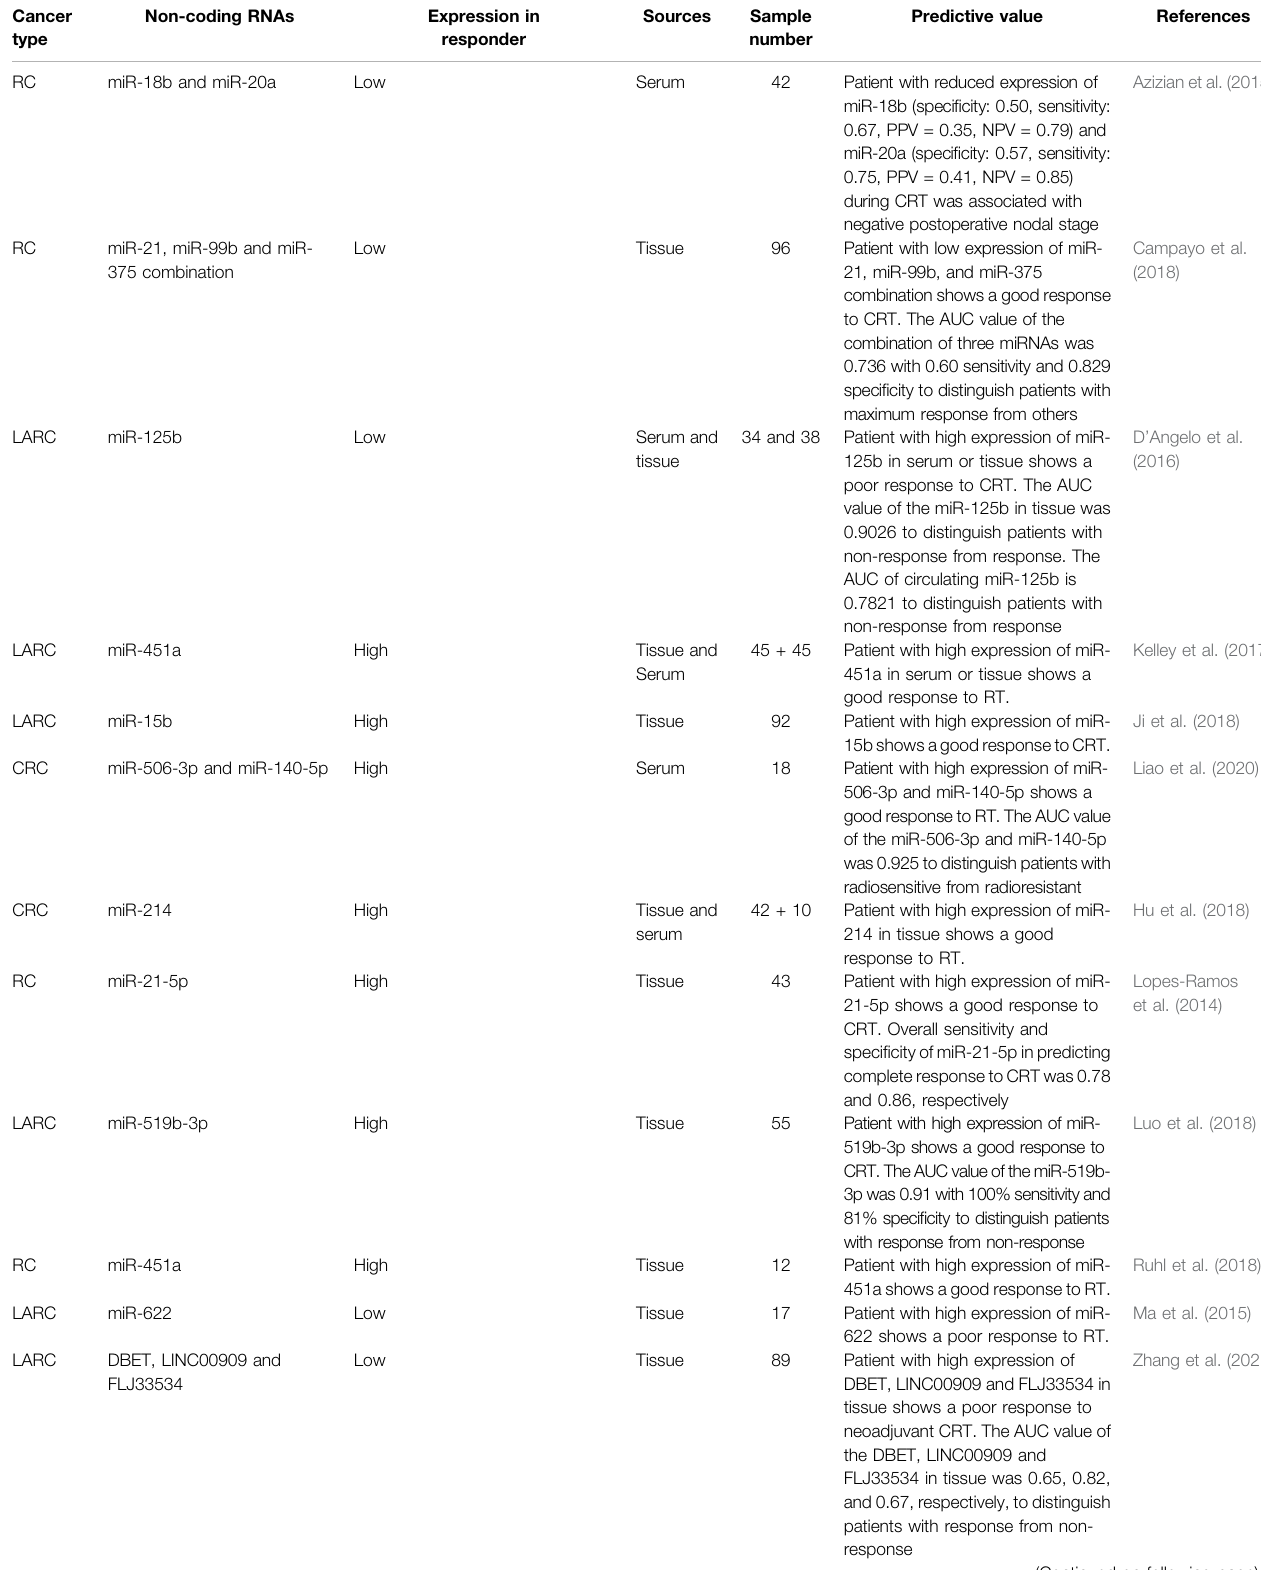
TABLE 3 | The predictive response of radiotherapy of non-coding RNAs in gastrointestinal